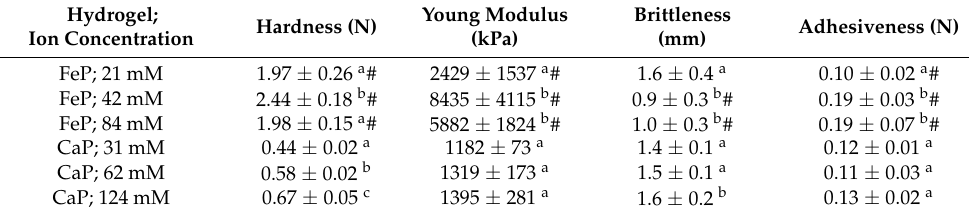
Table 1. Mechanical properties of the FeP and CaP hydrogels in a puncture test.